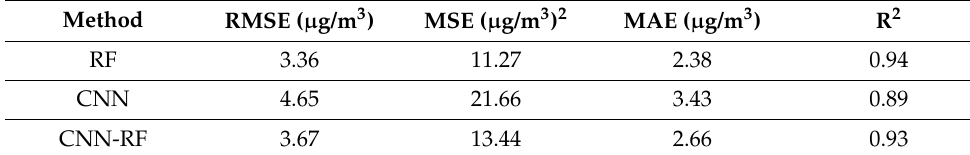
Table 3. Performance evaluation indicators for model training. Method